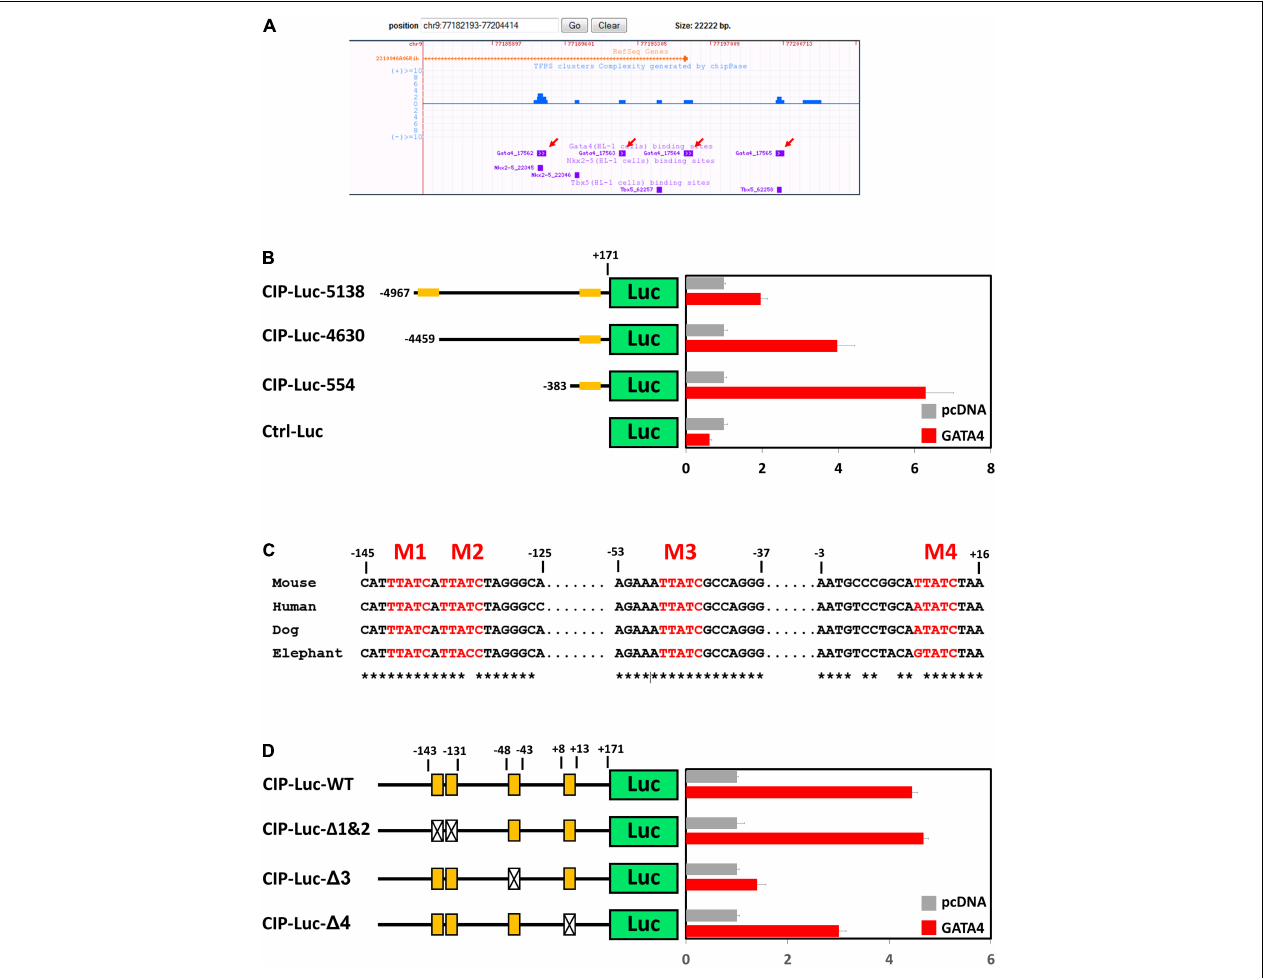
FIGURE 1 | GATA4 regulates the expression of cardiac ISL1-interacting protein (CIP). (A) Distribution of reported binding sequences for cardiac transcriptional factors around the transcriptional starting site of CIP gene in a genome browser. Red arrows indicate GATA4 binding sequences. (B) Luciferase reporter assay of reporters with full length or truncated CIP promotors with or without GATA4 activation. Orange bars indicate potential GATA4 binding sites. (C) Conservation of potential GATA4 binding motifs in mammalian, which are shown in red letters. Asterisks indicate the conserved nucleotides. (D) Luciferase reporter assay of reporters with full wildtype or mutant CIP promotors with or without GATA4 activation. Orange boxes indicate potential GATA4 binding motifs. Boxes with cross indicate mutant